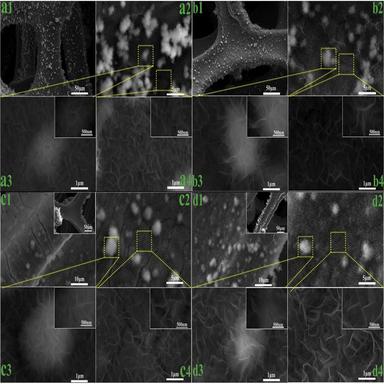
SEM images of NM@NC-8 (a1-a4); NM@NC-12 (b1-b4); NM@NC-16 (c1-c4) and NM@NC-20 (d1-d4).